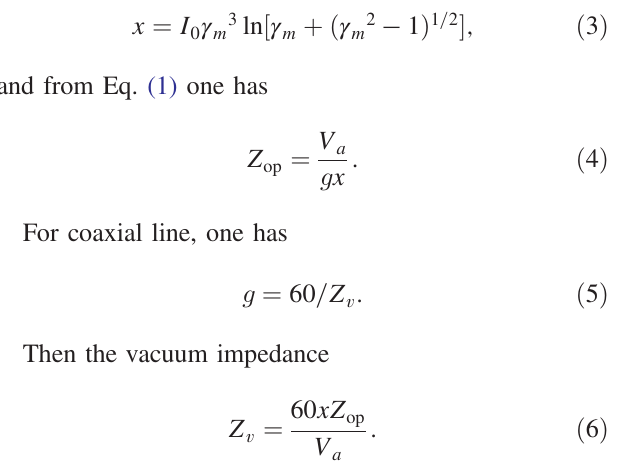
FIG. 2. Load current (red solid) and implosion kinetic energy (blue dash) from lumped circuit simulation for the concept design. The current and kinetic energy obtained on a Z-pinch load are 62 MA and 12.3 MJ, respectively.